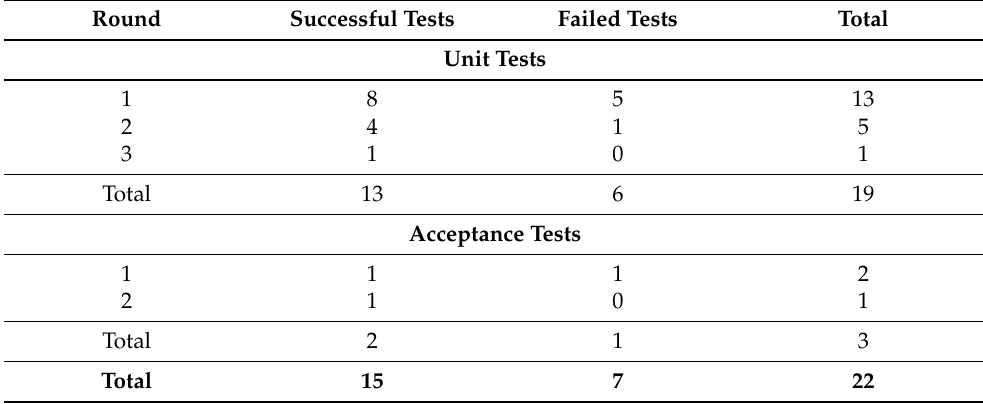
Table 5. Table of tests performed during the first